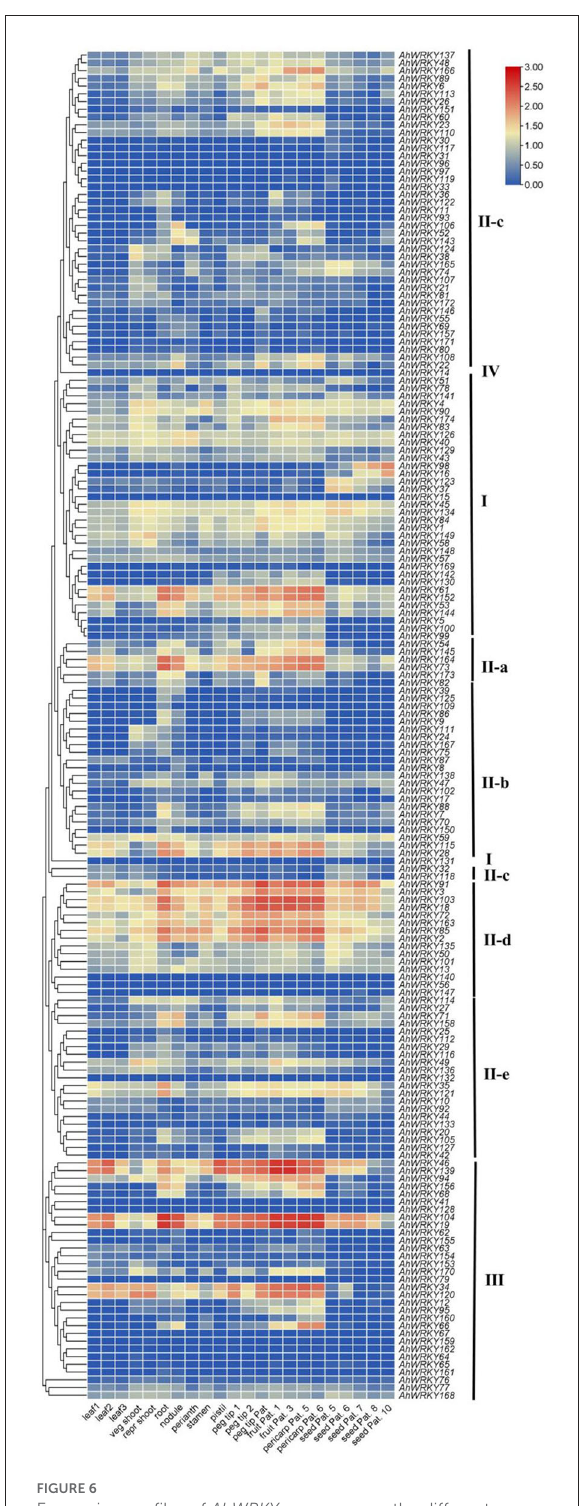
FIGURE6 Expression profiles of AhWRKY genes across the different tissues. Gene expression is expressed in l g (TPM + 1). Seedling leaf 10 days post-emergence (leaf 1), main stem leaf (leaf 2), lateral stem leaf (leaf 3), vegetative shoot tip from the main stem (veg shoot), reproductive shoot tip from first lateral (repr shoot),